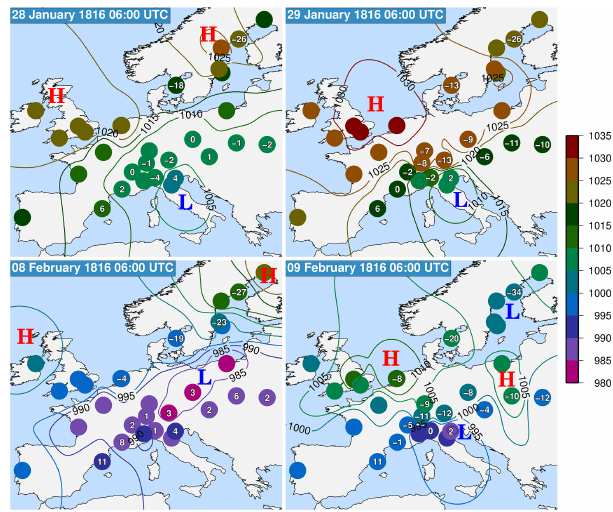
Figure 9. Synoptic maps for the two main cold spells in Europe during winter 1815/16. Coloured points represent SLP observations (in hPa). To facilitate interpretation, isobars at intervals of 5hPa are drawn using inverse distance weights, and the approximate position of pressure minima and maxima are indicated by the letters L and H, respectively. White numbers represent temperatures (in ◦ C) ob- served within ±